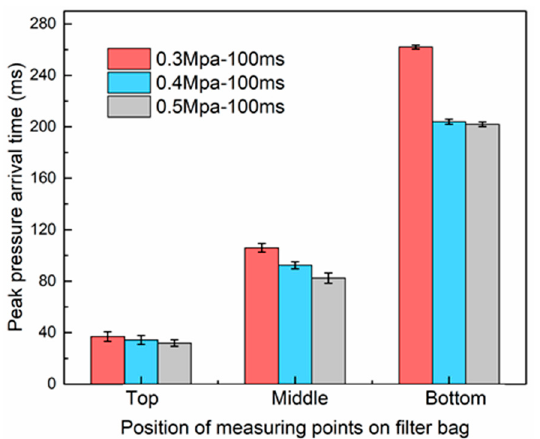
Figure 6. Effect of pulsing air pressure on the peak pressure arrival time. Figure 6. E ff ect of pulsing air pressure on the peak pressure arrival time. Appl. Sci. 2019 , 9 , x